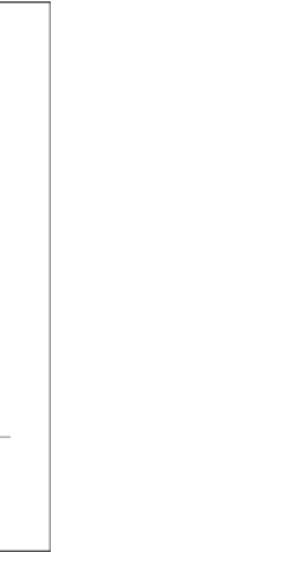
Fig 2. HBsAg kinetics during and after Peg-IFN therapy. The median HBsAg level from baseline to 12 months post-treatment declined from 3.4 to 2.6 log 10 IU/mL in all the patients, from 3.8 to 2.7 log 10 IU/mL in the HBeAg-positive patients, and from 3.2 to 2.5 log 10 IU/mL in the HBeAg-negative